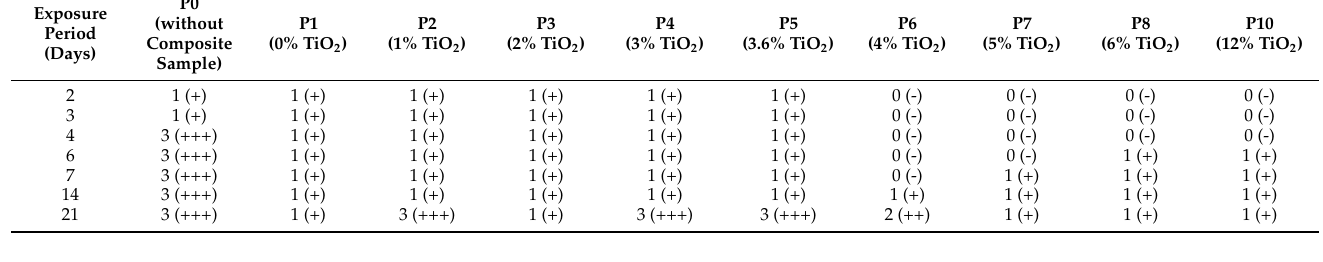
Table 3. Quantification of the microbiological load of the system according to STAS 12718 for samples exposed to Es- cherichia coli .